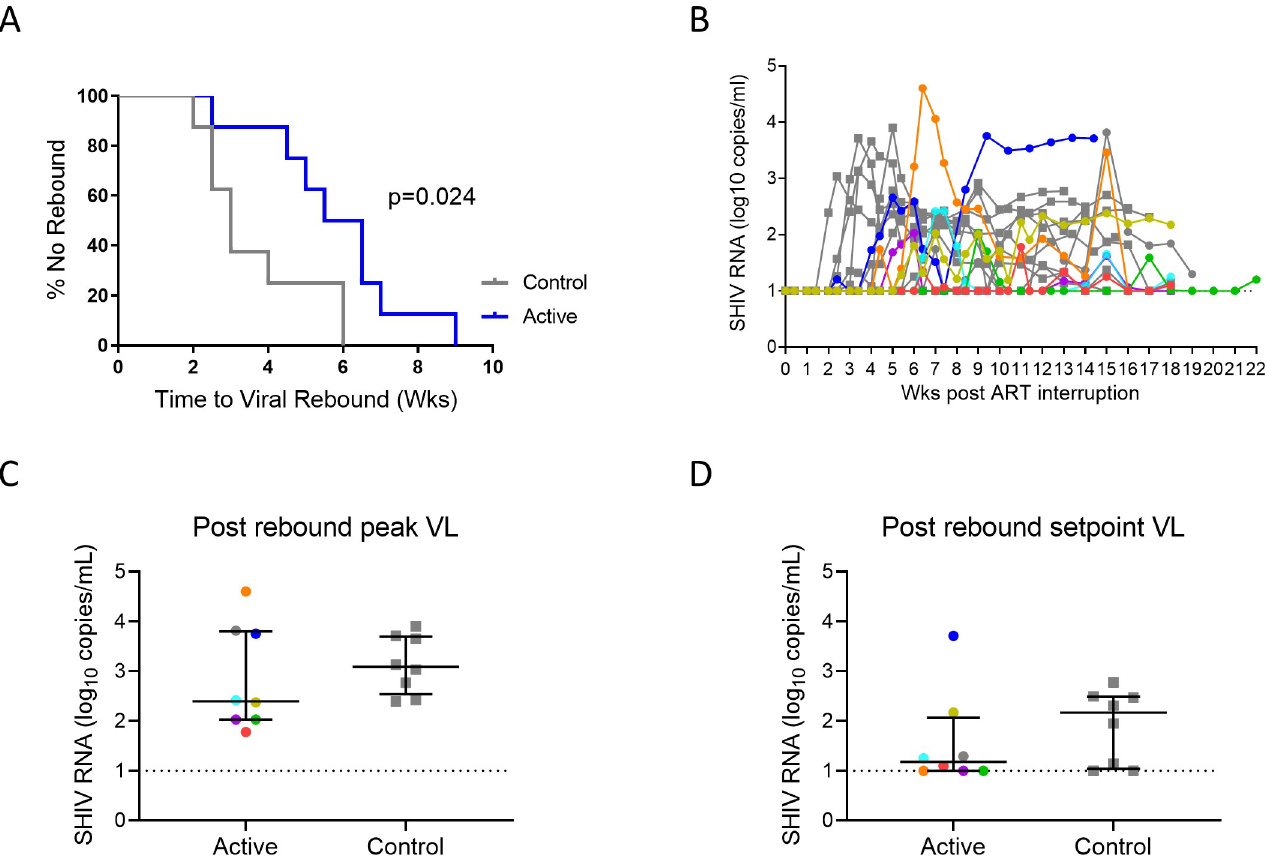
Fig 7. Impact of GS-986 and dual bnAbs on viral rebound after ART interruption. (A) The median time to viral rebound was 3 wks in the control arm (grey) vs 6 wks in the active arm (blue), p = 0.024. (B) Rebound trajectories for individual animals are shown. No differences were seen for (C) post-rebound plasma peak viral load or (D) viral setpoint between arms. Data from animals in the active arm are displayed in color with each color corresponding to individual animals identified in Fig 4A. Data from animals in the control arm are displayed as gray squares. Lines and error bars represent median and interquartile range. Dotted lines represent LOQ of SHIV RNA assay (10